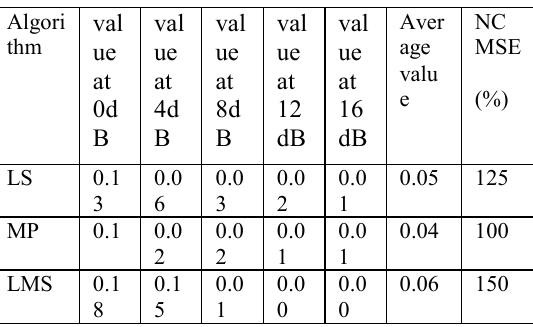
Table 2: Efficiency comparison on the basis of